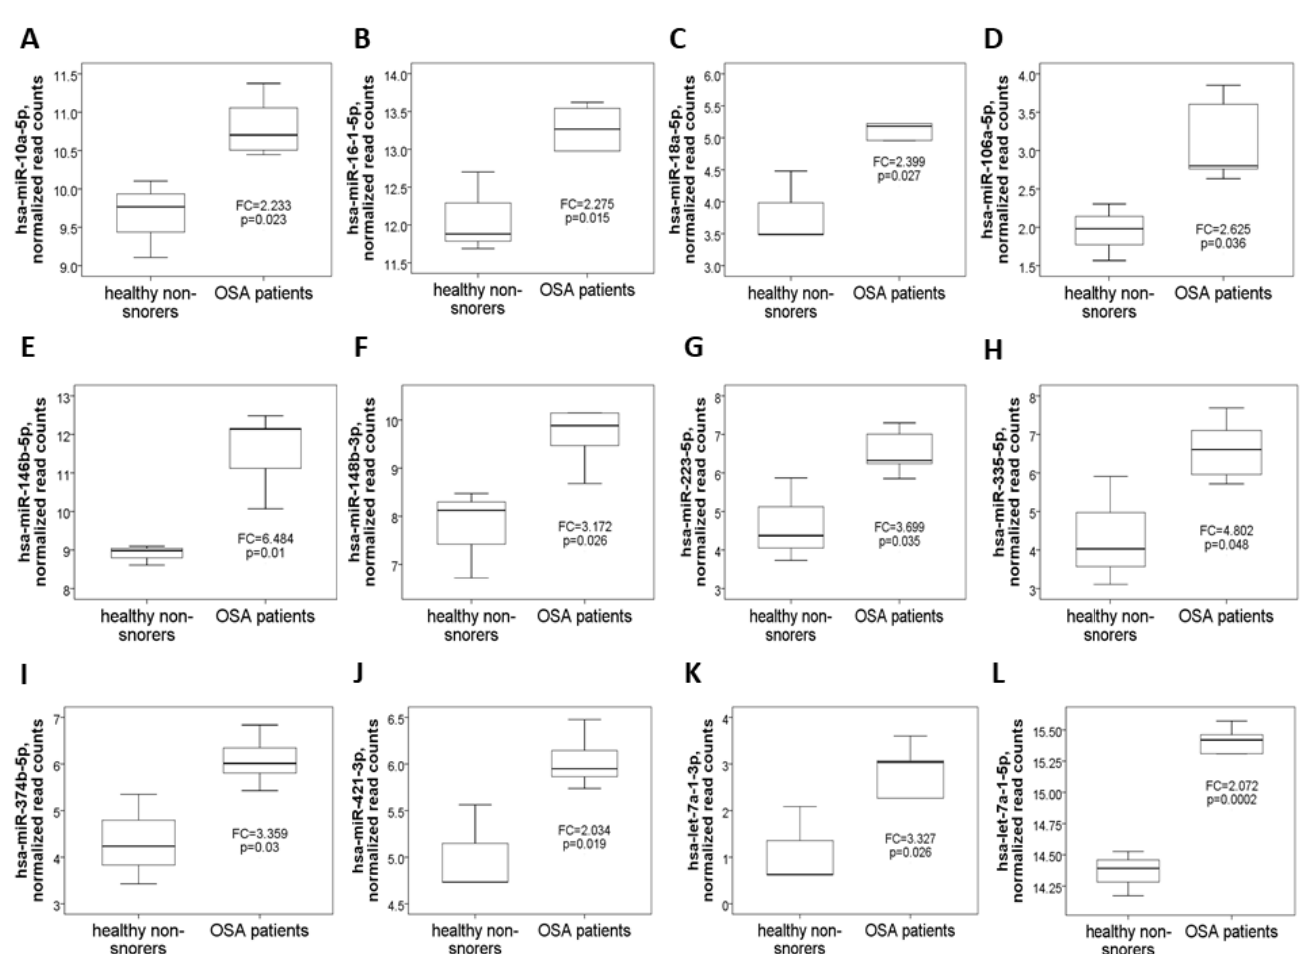
Figure 2. Twelve up-regulated microRNAs identified by next-generation sequencing in the comparison between OSA patients and healthy non-snorers in the discovery cohort. Normalized read counts of the ( A ) miR-10a-5p, ( B ) miR-16-1-5p, ( C ) miR-18a-5p, ( D ) miR-106a-5p, ( E ) miR-146b-5p, ( F ) miR-148b-3p, ( G ) miR-223-5p, ( H ) miR-335-5p, ( I ) miR-374b-5p, ( J ) miR-421-3p, ( K ) miR-let-7a-1-3p, and ( L ) miR-let-7a-1-5p genes were increased in OSA patients versus healthy non-snor- ers.